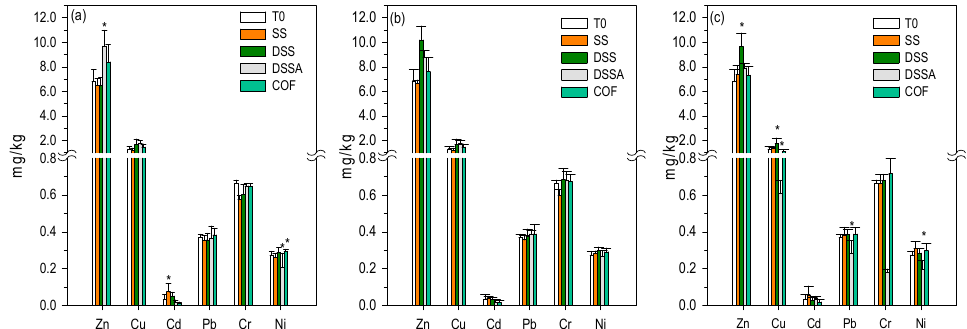
Figure 8. PTM content in the soil after lettuce growth for the different treatments: ( a ) T1—85 kg N/ha; ( b ) T2—170 kg N/ha; ( c ) T3—255 kg N/ha (T0—0 kg N/ha; SS—raw sewage sludge; DSS—dried sewage sludge; DSSA—dried sewage sludge with GLD; COF—commercial fertilizer; mean values and standard deviations obtained in four replicates of each treatment; treatments marked with * are statistically different; the statistical analysis was conducted separately for each figure).